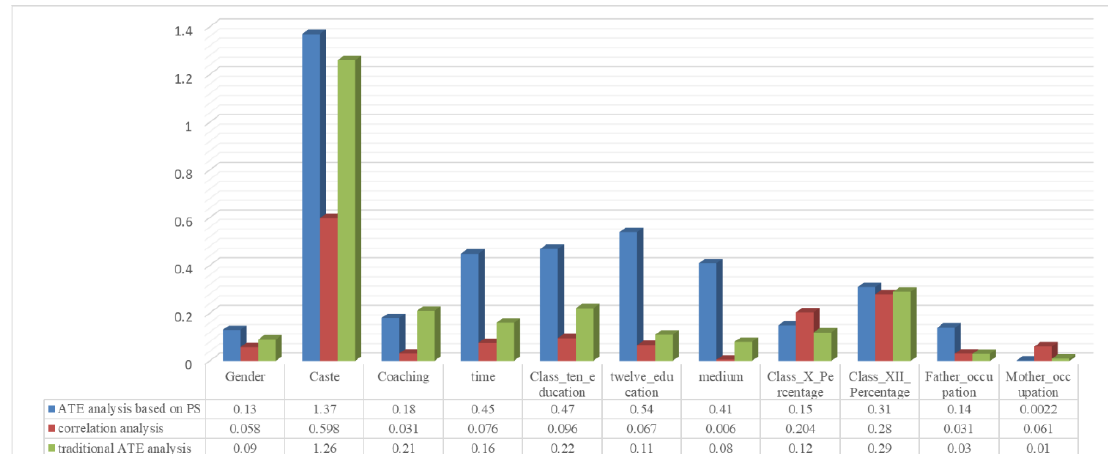
Figure 6. Comparison of the three methods.